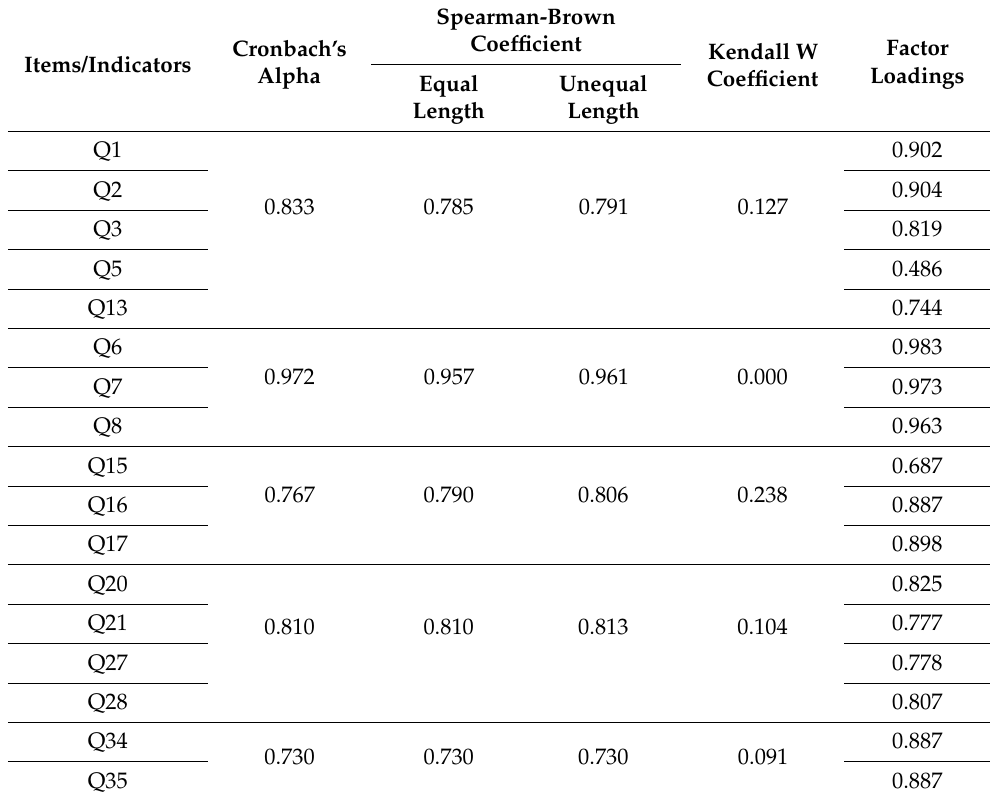
Table 2. Results of reliability, validity, and exploratory factor analysis of heavy mobile machinery operators—checklist questions.